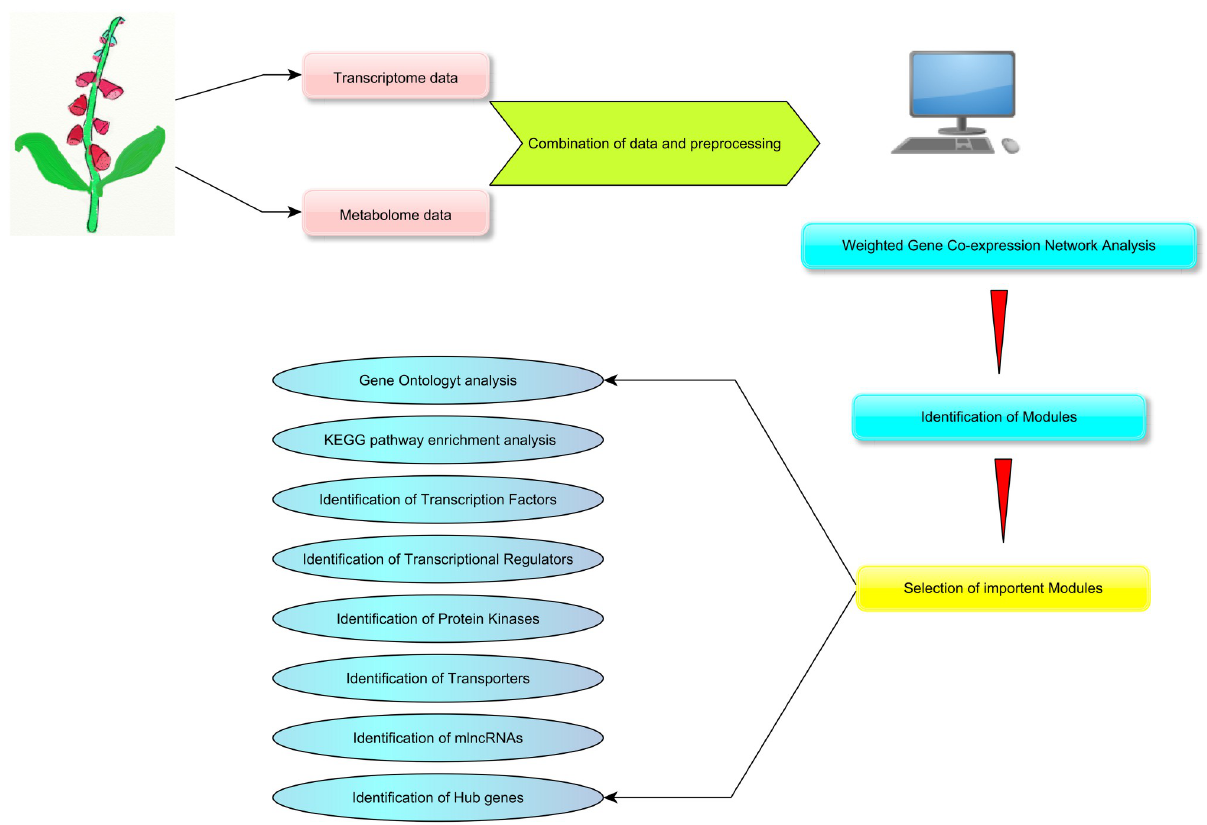
Fig 1. Flowchart of gene co-expression network analysis in D . purpurea . Data collection and analysis towards downstream analyses are shown.